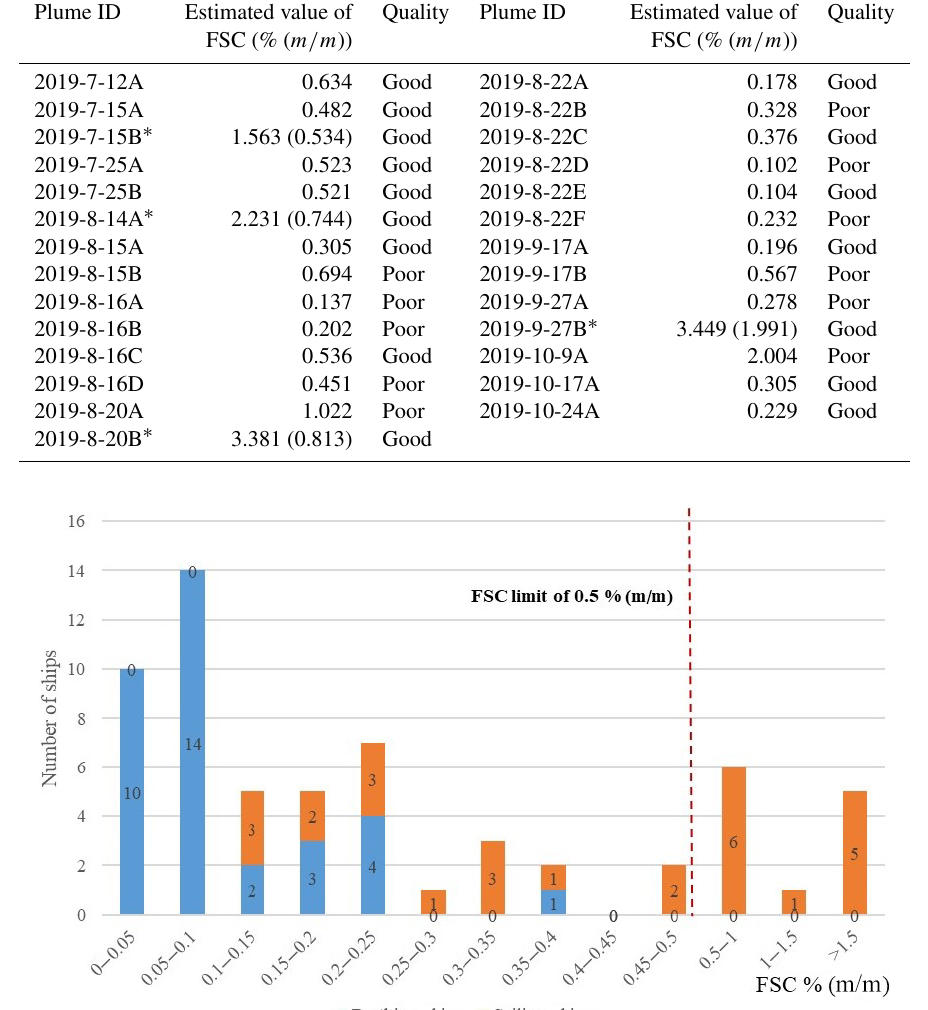
Table 4. Estimated (UAV) values of the FSC from 27 sailing ships. “ ∗ ” indicates that the ship was boarded by the maritime authority for inspection, and the value in parentheses is the result of the chemical examination of the fuel.